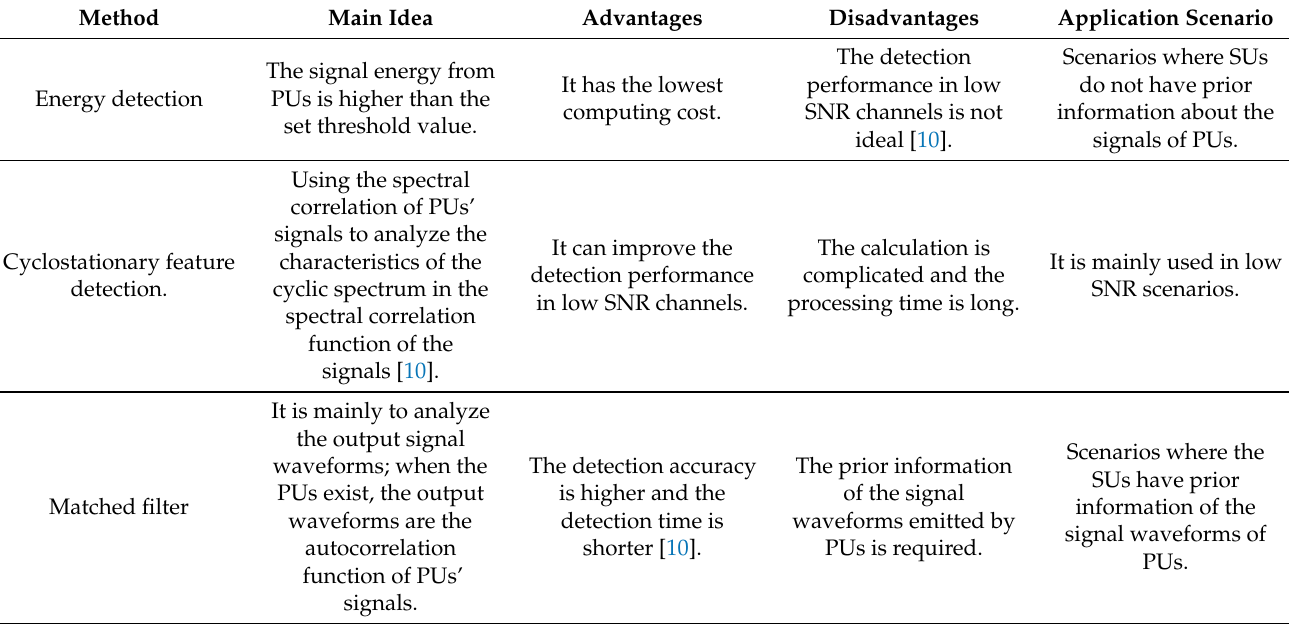
Table 7. Comparisons of energy detection, cyclostationary feature detection and matched